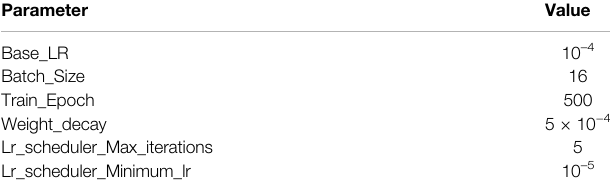
TABLE 3 | The initial parameters of the second